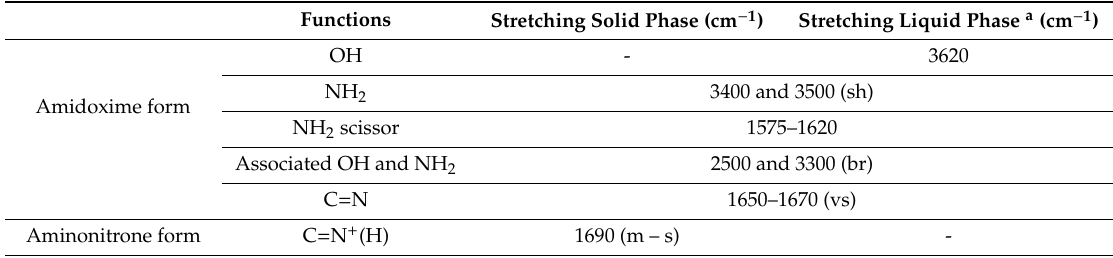
Table 1. Infrared bands in solid and liquid phases of amidoximes.